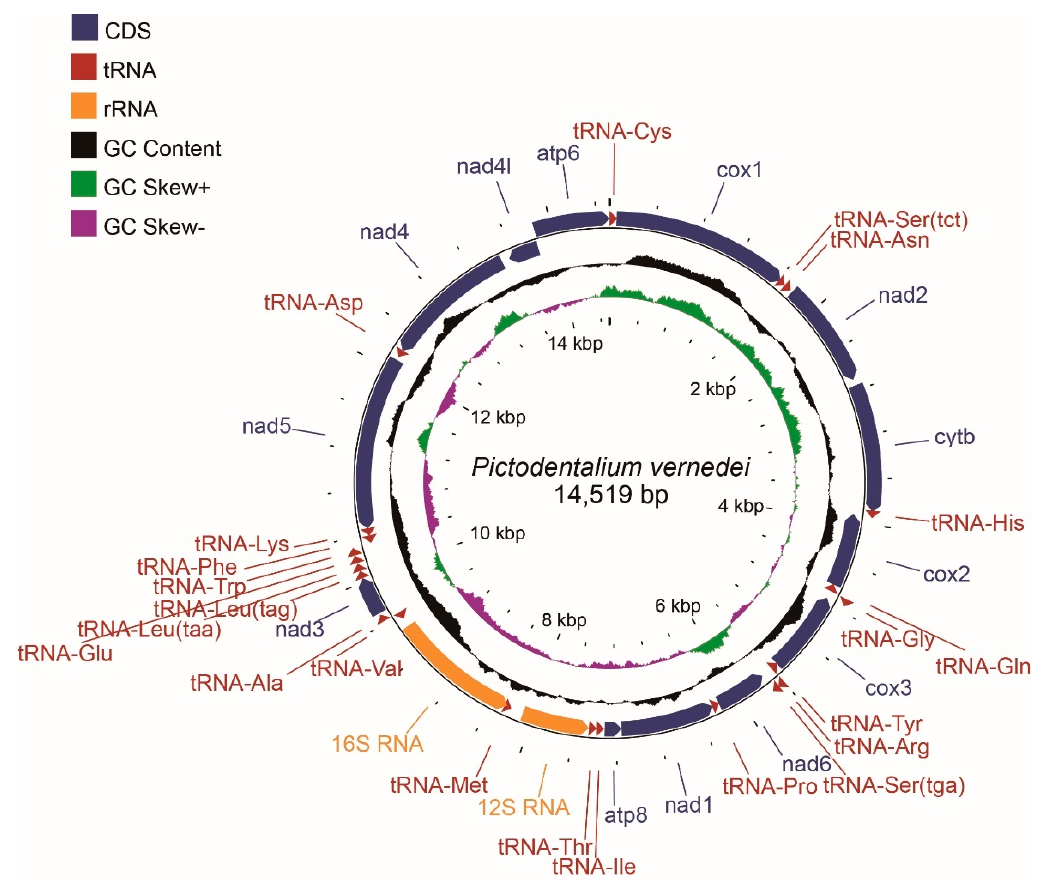
Figure 1. The overall mitogenome map of P. vernedei . From the inside to the outside, the innermost scale indicates the length, the inner circle indicates the G-C skew, the middle circle indicates the G-C content, and the outer circle indicates gene arrangement. The G-C skew was centered at zero while the G-C content circus was centered at 50%.